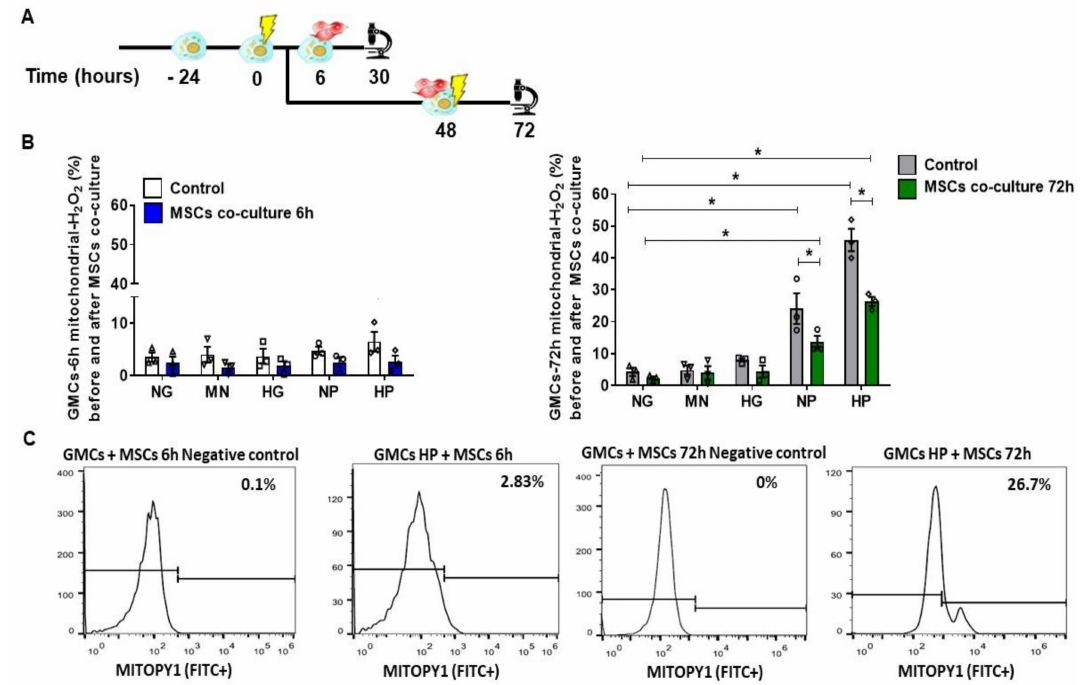
Figure 3. Anti-oxidative effect of MSCs co-culture on GMCs conditioned with stress media. ( A ) Scheme of the cellular experiments for GMCs conditioning with stress-conditioning media at different time-points (6 h and 72 h) and the subsequent MSC co-culture 24 h-therapy. ( B ) Mitochondrial accumulation of H 2 O 2 after 6 h and 72 h conditioning following MSCs co-culture 24h-therapy. NP and HP media had significantly diminished ROS accumulation in the 72 h time-point (* p < 0.05). ( C ) Flow cytometry gating and negative control for mitochondrial-H 2 O 2 accumulation in GMCs conditioned for 6 h and 72 h in HP medium. Specific accumulation of H 2 O 2 in mitochondria (FITC + ) of GMCs conditioned to stress media after MSCs co-culture (normal glucose—NG, mannitol—MN, hyper glucose—HG, normal glucose + hydrogen peroxide—NP, hyper glucose + hydrogen peroxide—HP) during 6 h and 72 h time-points. Error bars represent mean ± SEM; n = 3, * p <